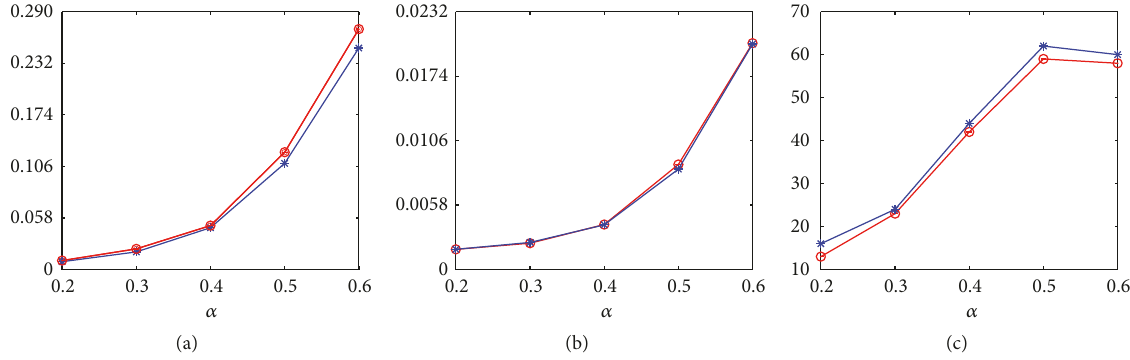
Figure 13: Comparison of three quantities of rumor propagation before and after deleting 10 nodes in Ca-GrQc: (a) the average propagation size, (b) the averagepeak prevalence,and (c) the arrival time of the averagepeak prevalence(red circles representthe situation before deleting and blue stars represent the situation after